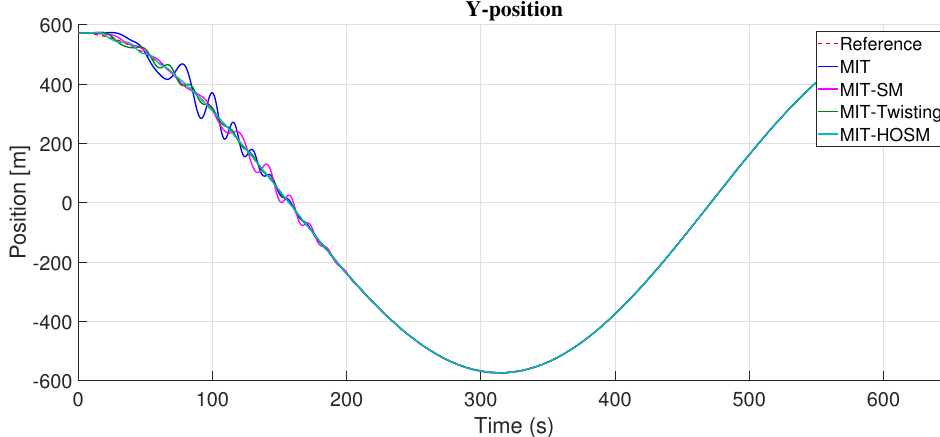
Figure 5. Trajectory following in